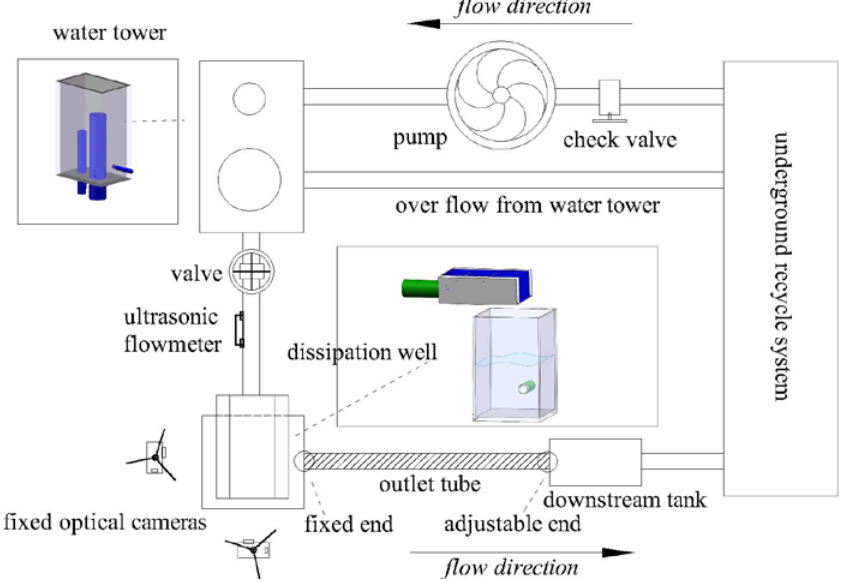
Figure 1. Generalized layout of the experiment platform.